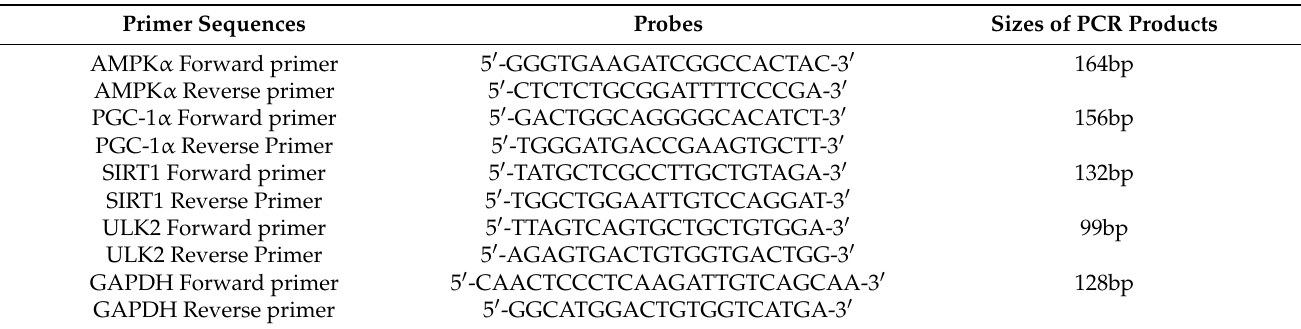
Table 1. The primers information used for real-time PCR